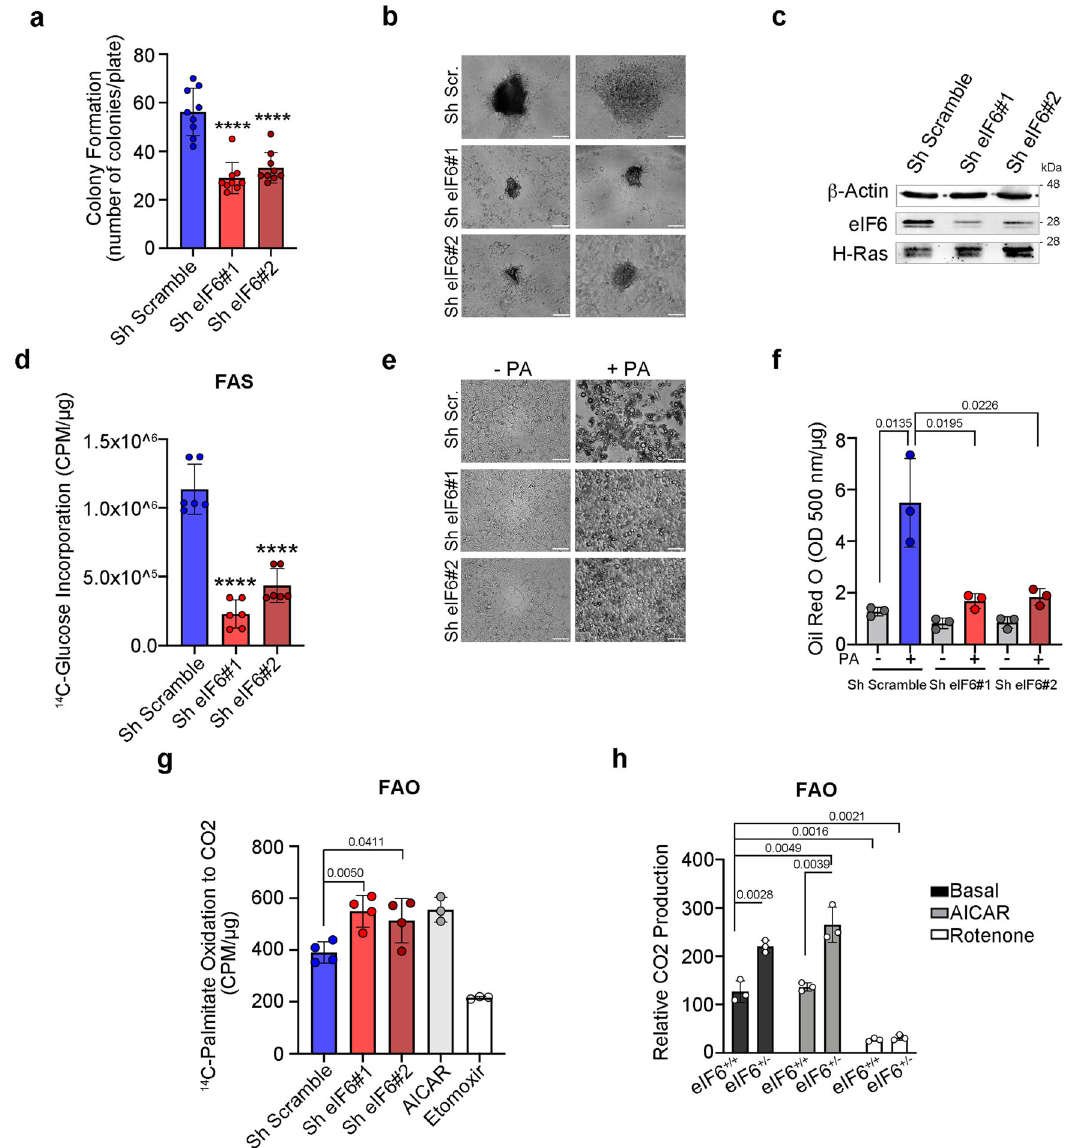
Fig. 2 Downregulation of eIF6 prevents oncogenic transformation, lipid synthesis, and activates palmitate-stimulated fatty-acid oxidation. a – c Reduced transformation by eIF6 depletion. Control and eIF6-silenced cells were transduced with DNp53-H-Rasv12 retrovirus: the number of transformed tumor colonies are reduced in eIF6-silenced cells. Data are represented as means ± SD of n = 9 plates/condition; **** p value ≤ 0.0001 a . Bright- fi eld images of transformed colonies. Scale bars = 100 µ m b . eIF6 levels in wt and silenced eIF6-transformed cells. Anti H-Ras antibody was used as a control for retroviral infection c . d FAS (fatty-acid synthesis) analysis on AML12 control and eIF6-silenced cells: eIF6 downregulation reduces 14 C-Glucose incorporation ( n = 6). Two-tailed t test. **** p value ≤ 0.0001. e Representative images of AML12 treated with 2 mM palmitate or ethanol, as control: depletion of eIF6 by shRNA reduces intracellular lipid accumulation. Scale bar = 50 μ m. f Quanti fi cation of Oil Red O staining with or without exogenous palmitate addition. N = 3. Lipid droplets accumulation is reduced in eIF6-depleted AML12 cells. Data are represented as means ± SD. Two-tailed t test. *** p value ≤ 0.001. g FAO (fatty- acid oxidation) rates were measured on 14 CO 2 release upon administration of exogenous 14 C-palmitate. Data are means ± SD ( n ≥ 3). AICAR and Etomoxir were used as positive and negative controls, respectively. Two-tailed t test. h FAO rates in isolated livers from WT and eIF6 + / − mice either in the presence of AICAR or rotenone. N = 3. Two-tailed t test. Data are means ± SD. Data are provided as a Source Data maximal size, >10 mm in diameter, only in eIF6 + / + mice (Fig. 5f).